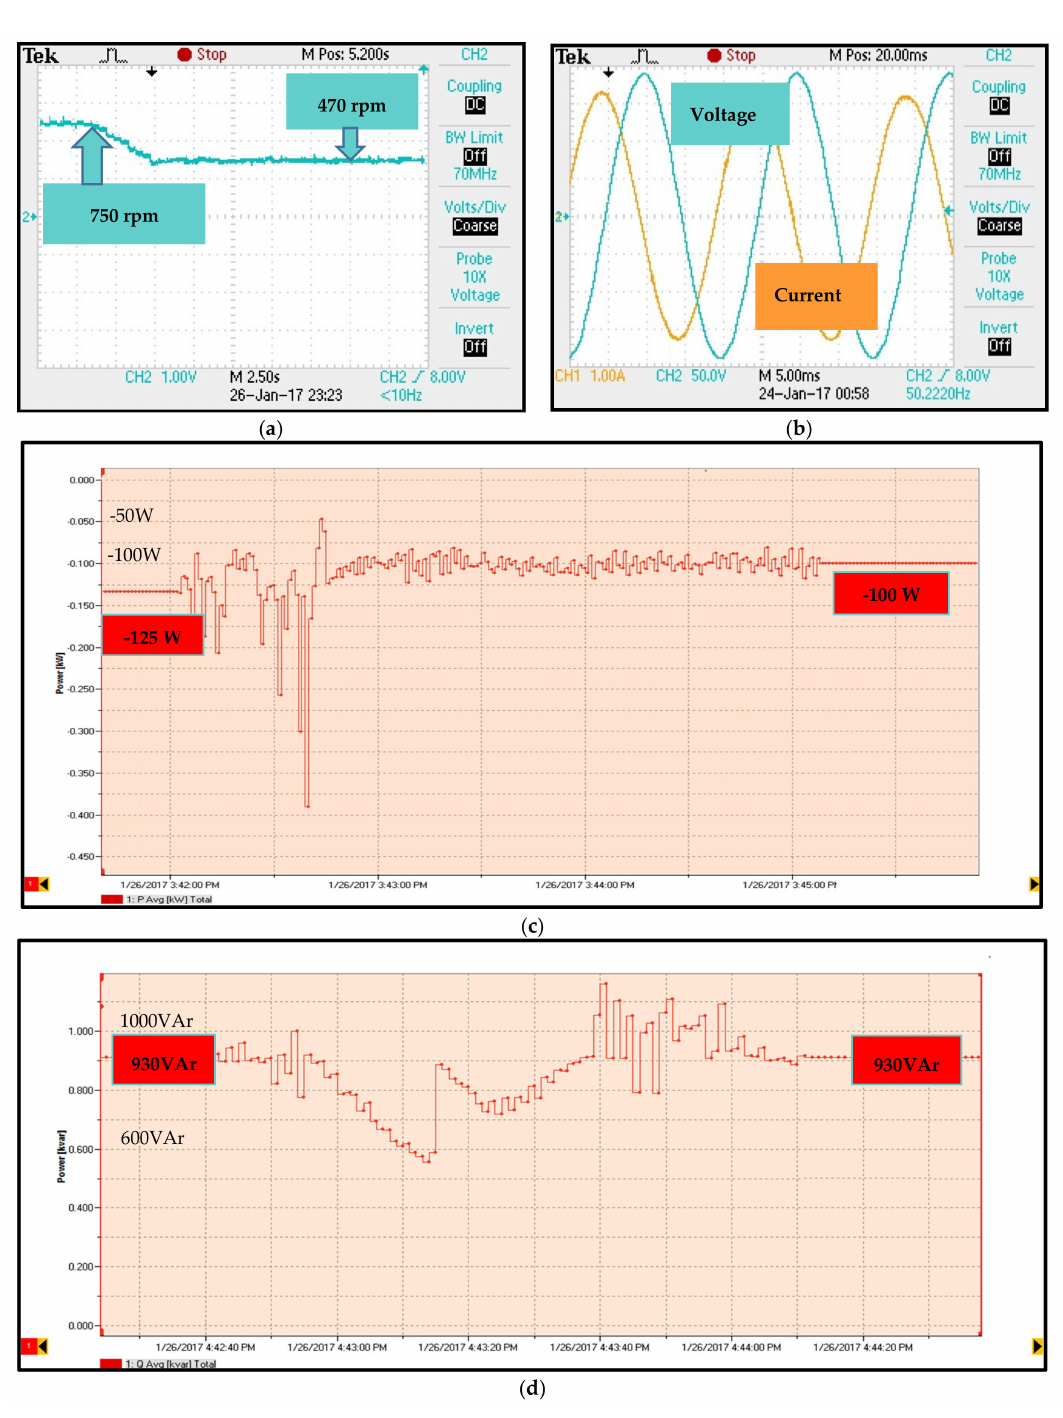
Figure 16. Grid side experimental waveforms for no load test (2): ( a ) speed (V), ( b ) phase A grid voltage and current, ( c ) grid active power (W) [ Y-axis: 25 W / div, X-axis: 30 s / div ], and ( d ) grid reactive power (VAr) [ Y-axis: 100 VAr / div, X-axis: 10 s / div